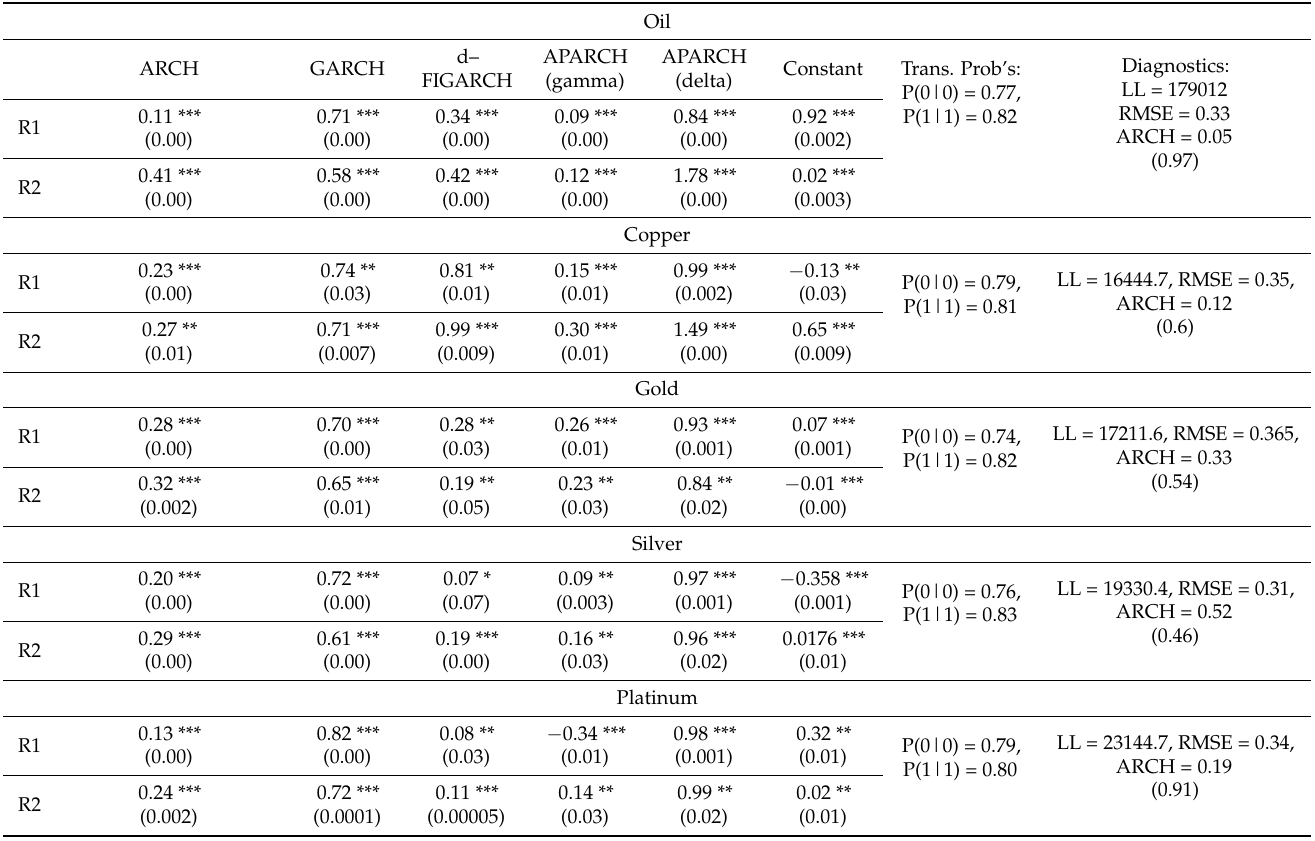
Table 6. MS–FIAPGARCH–Copula Model Estimation